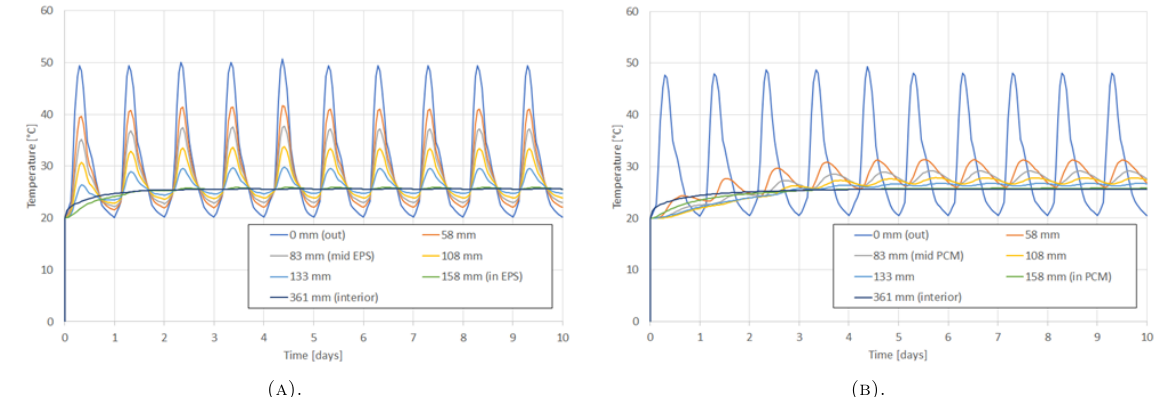
Figure 7. Temperature evolution for EPS (A) and PCM-336 (B) insulation at various distances from outer surface for the warm case with cooling.